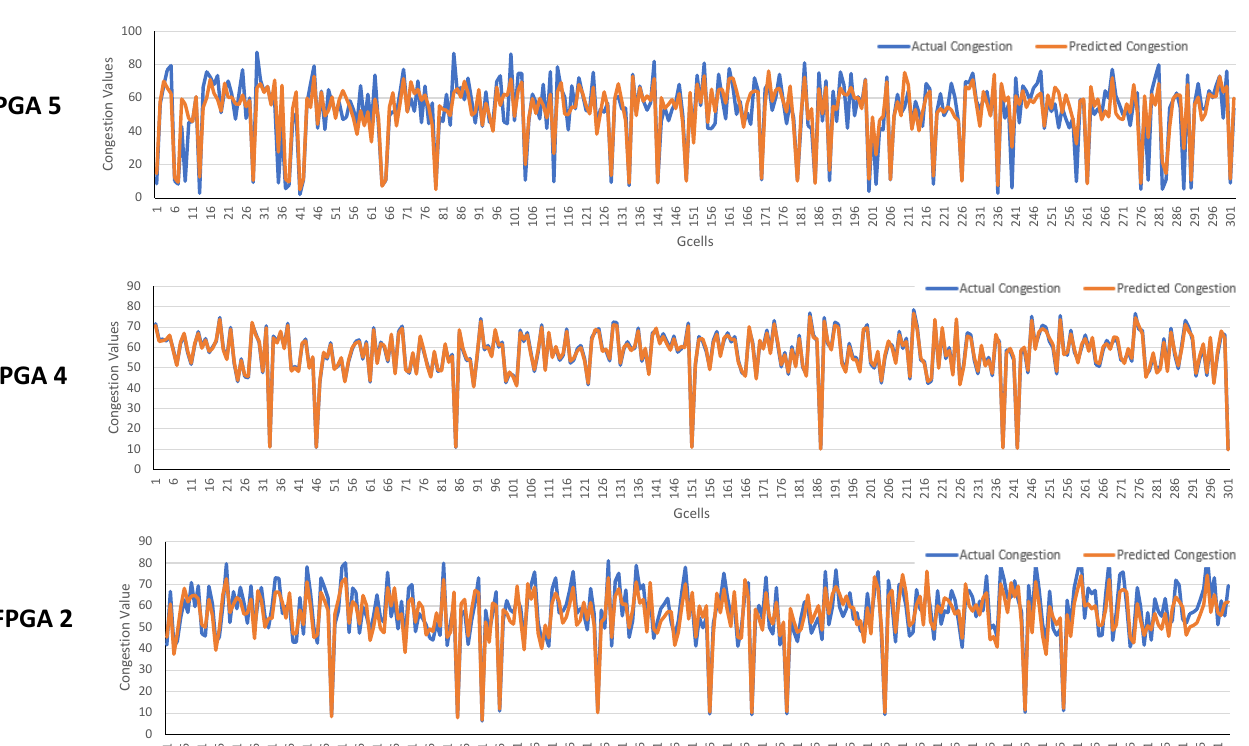
Figure 9. Graphical comparison of congestion density values between actual congestion reported by Xilinx tools and the congestion predicted by the prediction